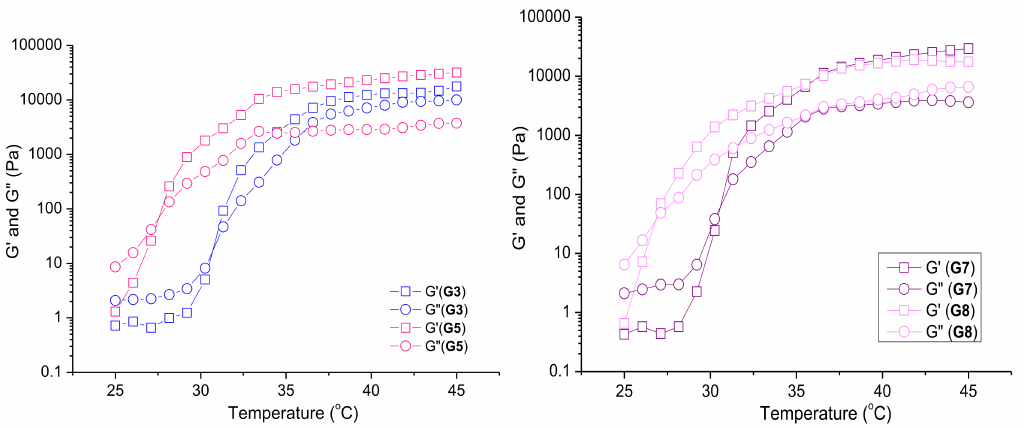
Figure 4. Dependence of storage (G (cid:48) ) and loss (G (cid:48)(cid:48) ) moduli on temperature for pure polymer formulations, G3 and G5, on the left side, and niosome-containing formulations, G7 and G8, on the right side.